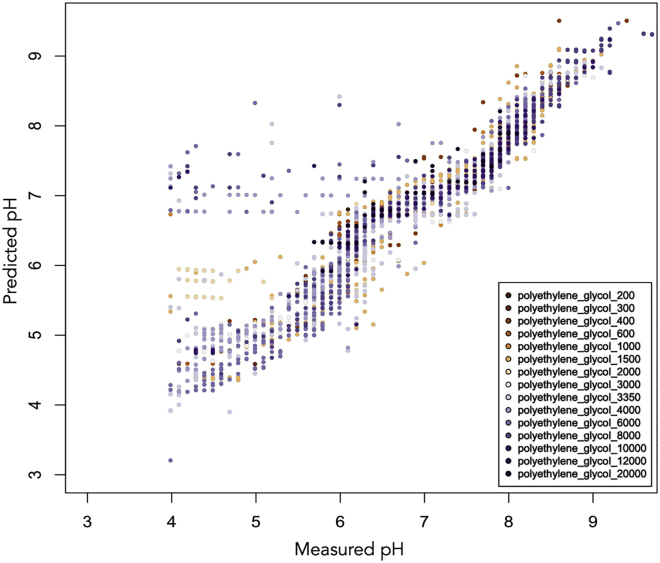
Predicted pH Values Plotted against the Measured pH for Wells Containing PEGs (with No Other Additives Except Buffer)Two subgroups with poor predictions can be seen: those with measured pH values between 4 and 5.5 and a predicted pH value between 5 and 6.5 mainly correspond to PEGs with molecular weight 1.5K or 2K, whereas those with predicted pH between 6.5 and 8.5, although the measured pH is often very acidic, correspond to PEGs with higher molecular weight (4K–8K).